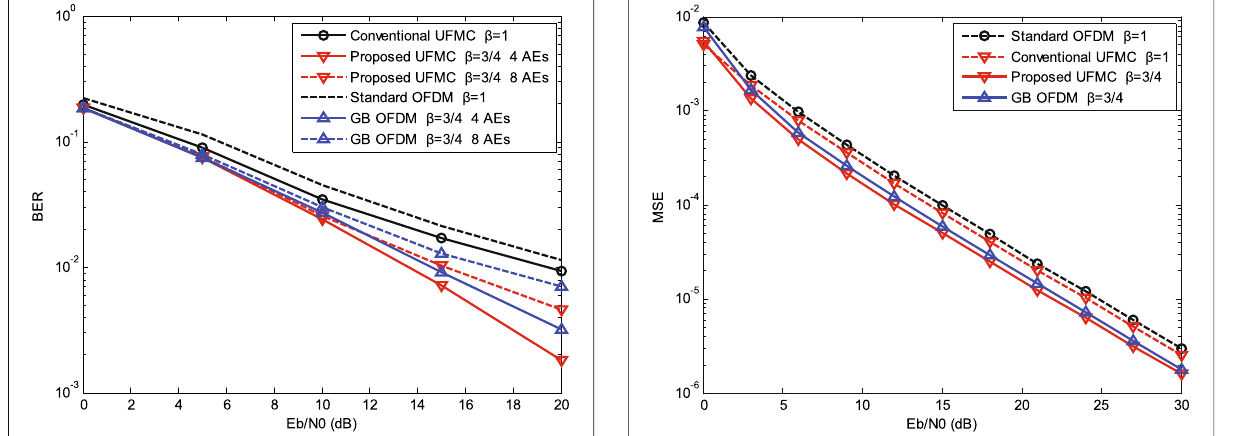
Fig. 7 BER performance evaluation of different number of AE for the proposed UFMC. This figure illustrates the effect of the different number of AE on BER performance and compared with the other